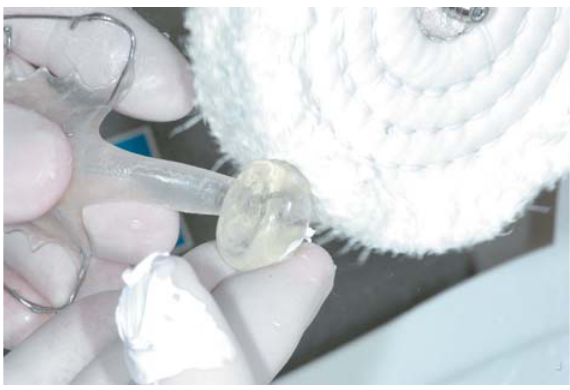
Figure 5- Pharyngeal obturator reduction with grinding paste – phase of